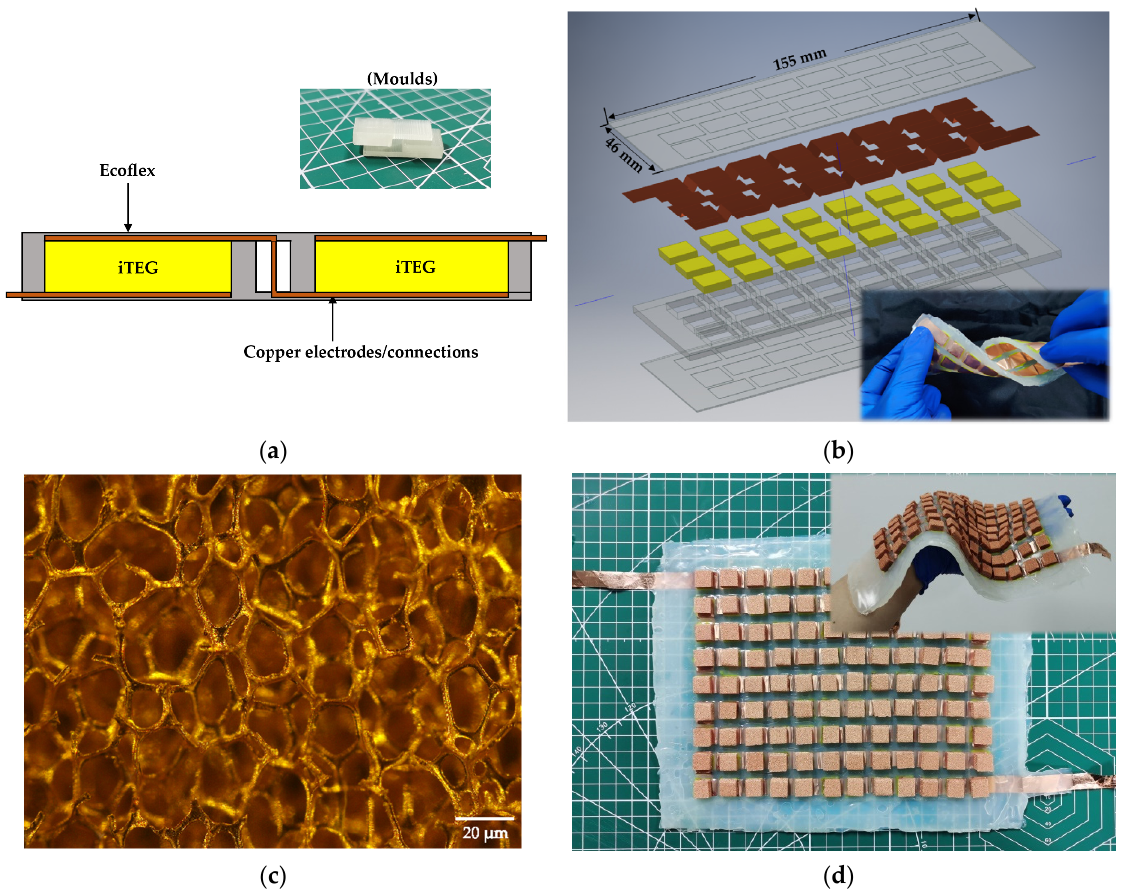
Figure 3. ( a ) The assembly relationship of the flexible frame, films, electrodes and iTEG units in the TEG (inset is the photo of the 3D-printed die); ( b ) 3D exploded diagram of the flexible wearable STEG (inset is the photo of a finished flexible STEG); ( c ) microscopic picture of the copper foam; ( d ) photos of the LTEG.